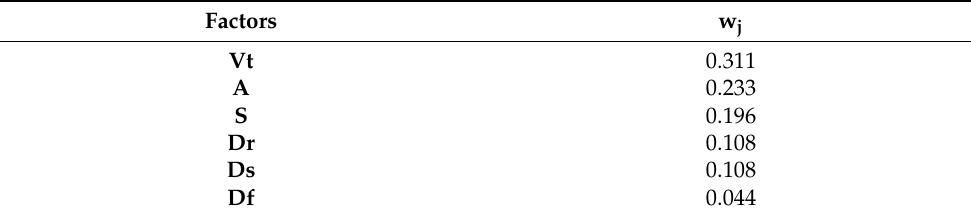
Table 7. Weighted values (w j ) of factors obtained from the fuzzy AHP method.